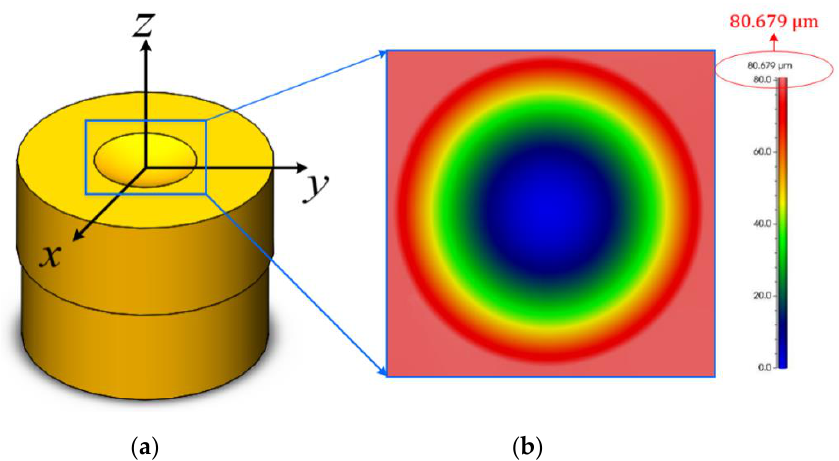
Figure 1. The model of the elliptical paraboloid and detection results of the 3D surface profile: ( a ) the model of the elliptical paraboloid; ( b ) the 3D surface profile for the model.